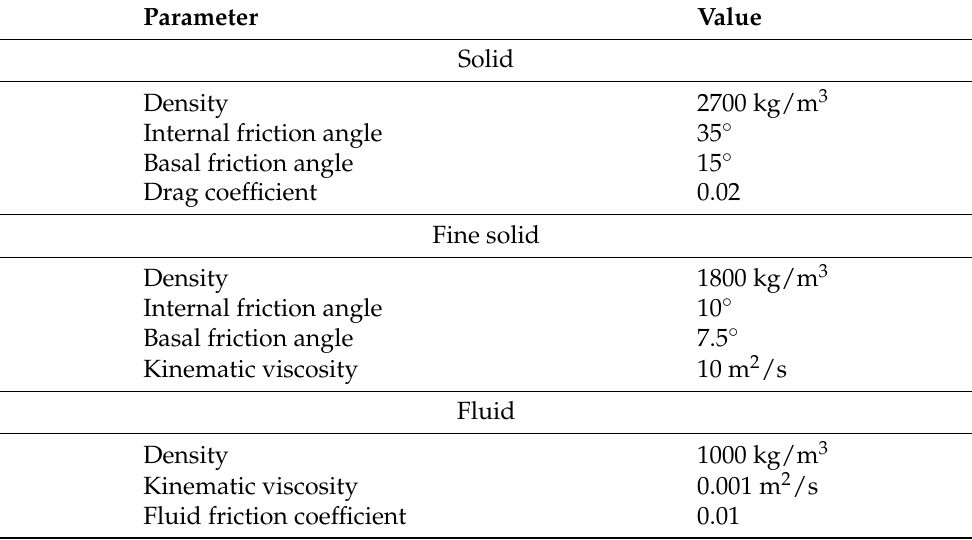
Table 3. Key parameters used in the numerical